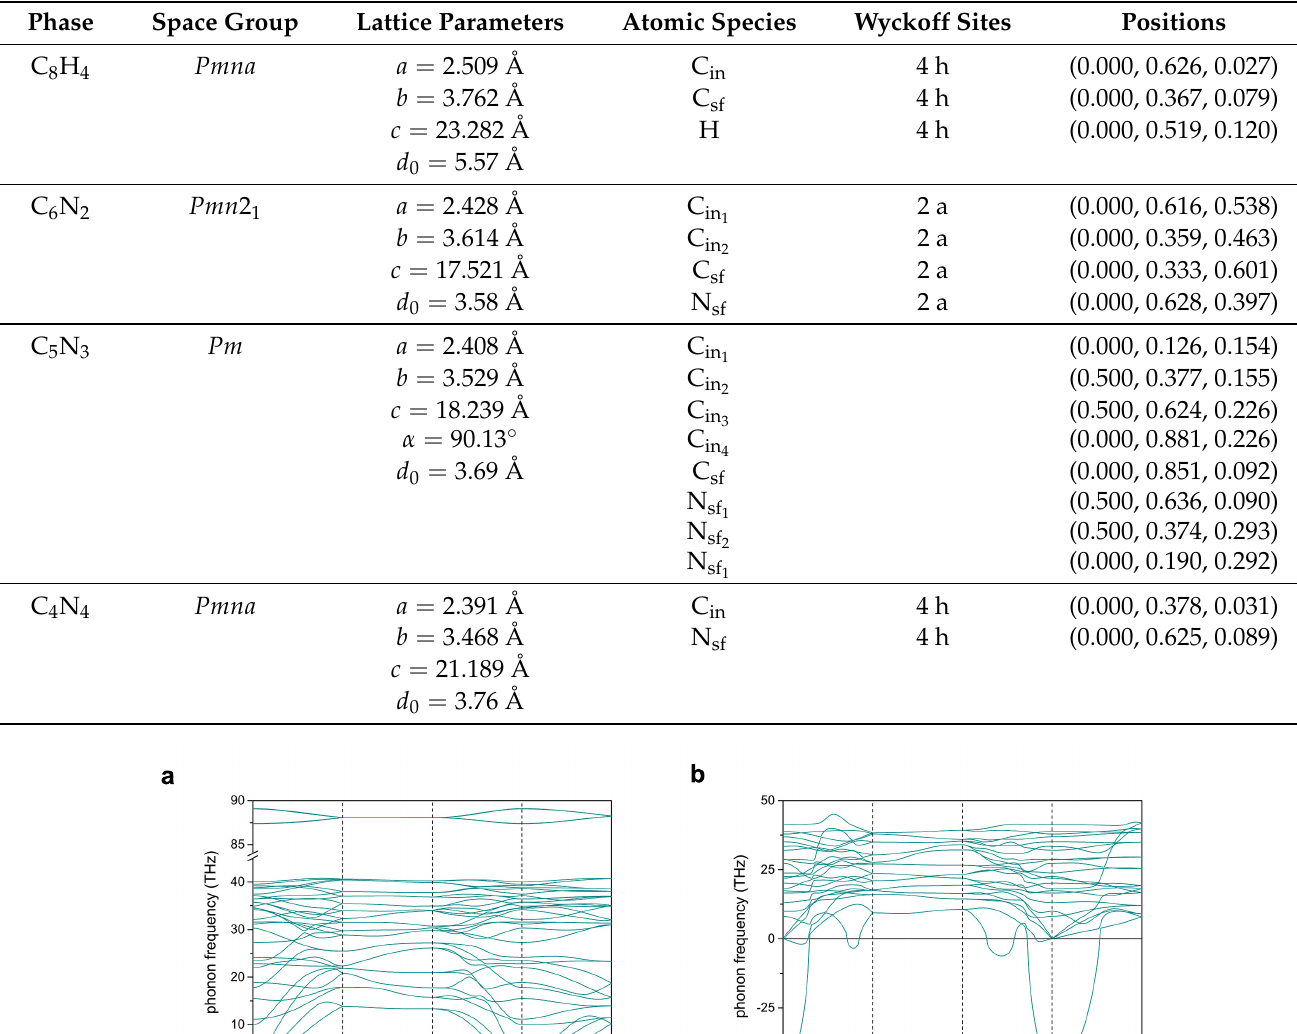
Table 1. The relaxed structures of C 8 H 4 , C 6 N 2 and C 4 N 4 are reported. The atomic species with subscript sf and in indicate an atom on the surface and atom in the inner layer, respectively.